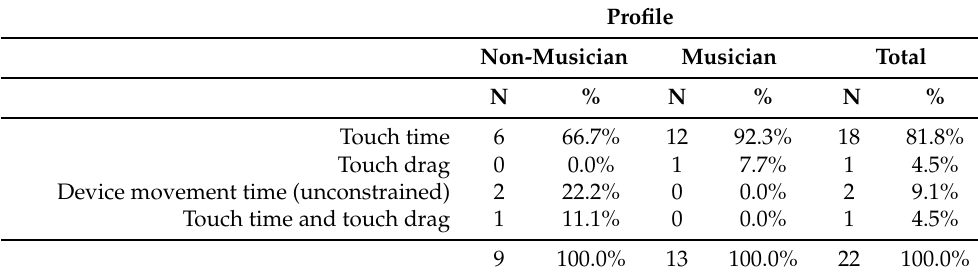
Table A14. Duration variation mapping (uncategorized)—stimulus d.